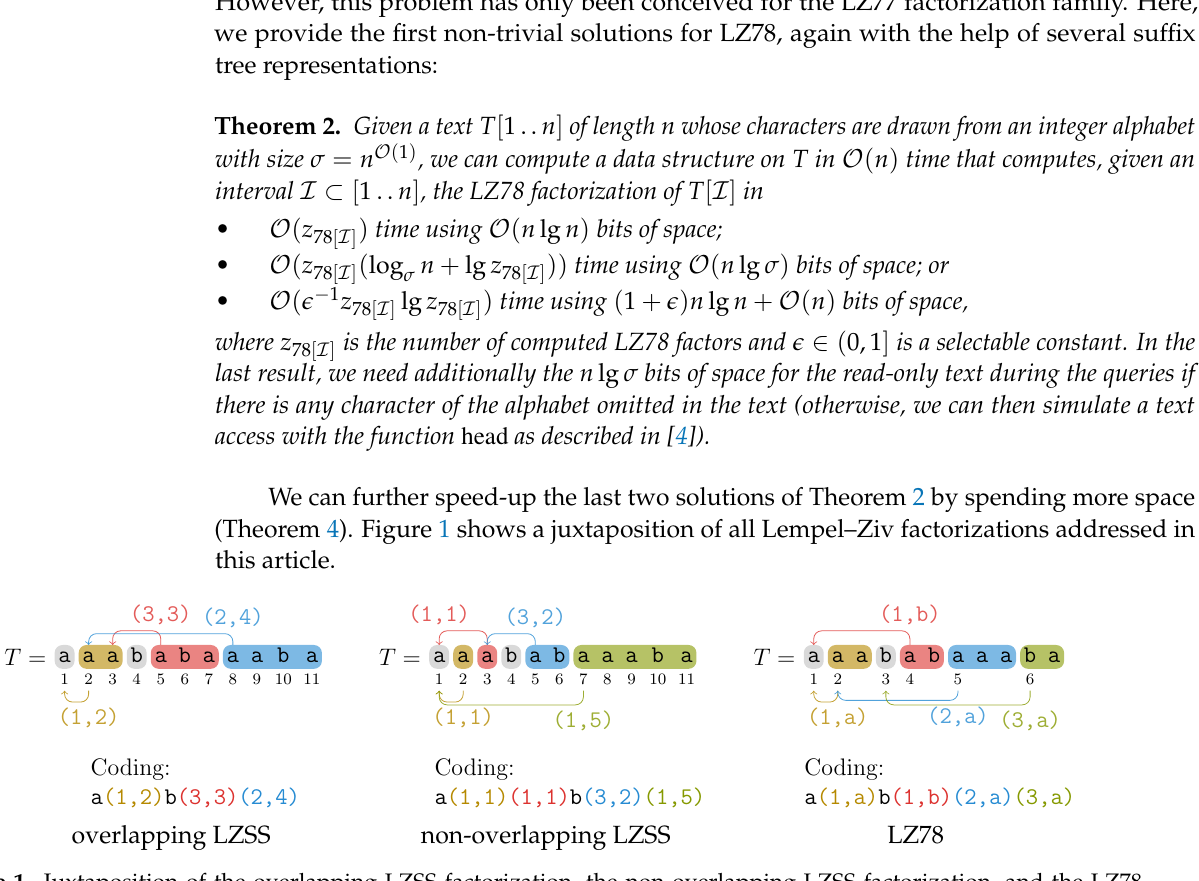
Figure 1. Juxtaposition of the overlapping LZSS factorization, the non-overlapping LZSS factorization, and the LZ78 factorization on the string T = aaababaaaba . A factor is visualized by a rounded rectangle. Its coding consists of a mere character if it has no reference; otherwise, its coding consists of its referred position and its lengths for both LZSS variants or its referred index and its last character for